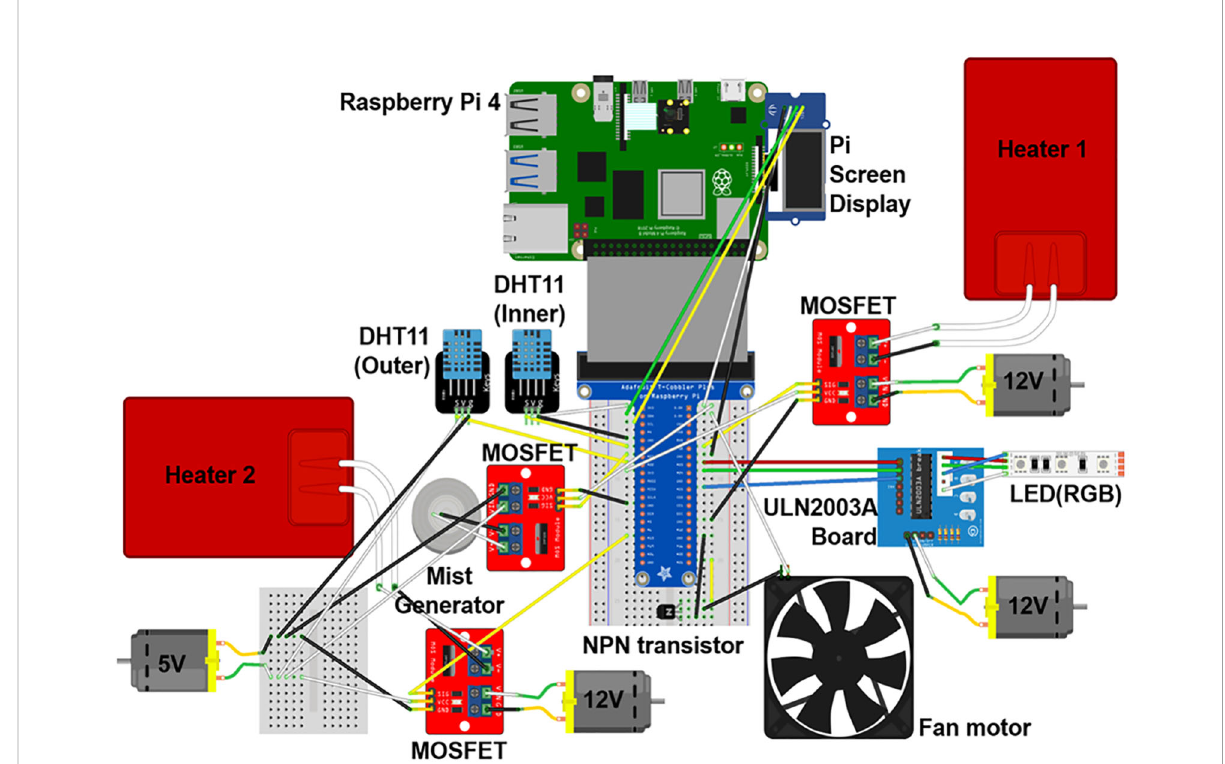
FIGURE 3 Circuit design between Raspberry Pi and the other components.